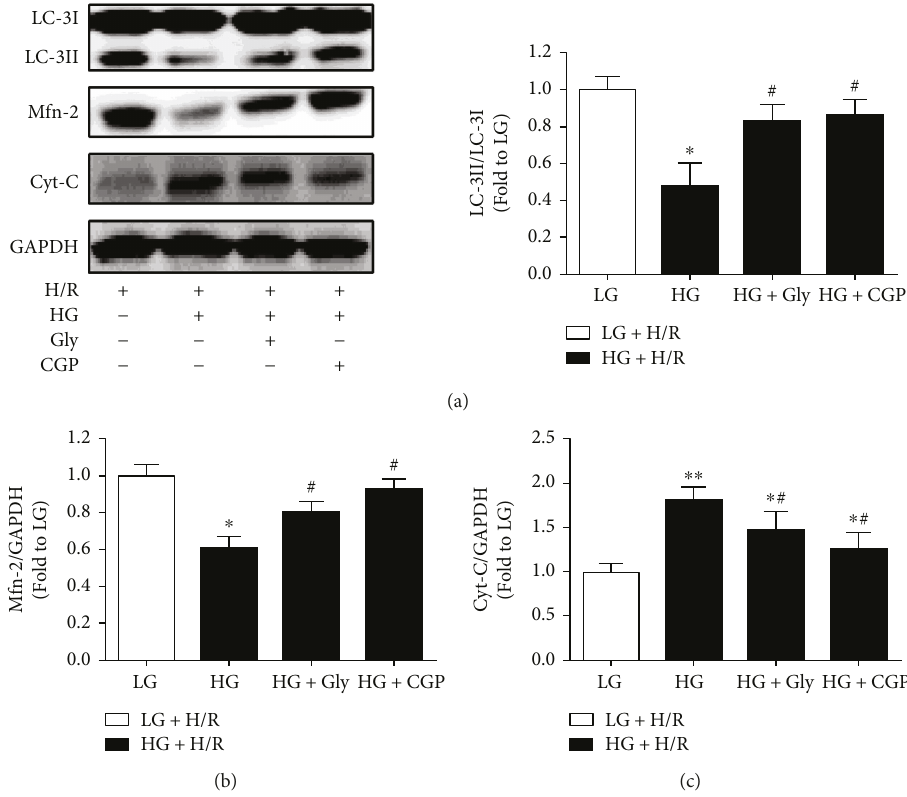
Figure 5: E ff ects of glycine (Gly) and CGP53353 (CGP) on LC-3II (a), Mfn-2 (b), and Cyt-C (c) expression in H9C2 cells subjected to high glucose (HG) and hypoxia/reoxygenation (H/R) insult. All the results are expressed as mean ± SD ( n = 8 ). Di ff erences were determined by using one-way ANOVA followed by Tukey ’ s post hoc test. ∗ P < 0 05 , ∗∗ P < 0 01 versus LG (low glucose)+HR groups, and # P < 0 05 versus